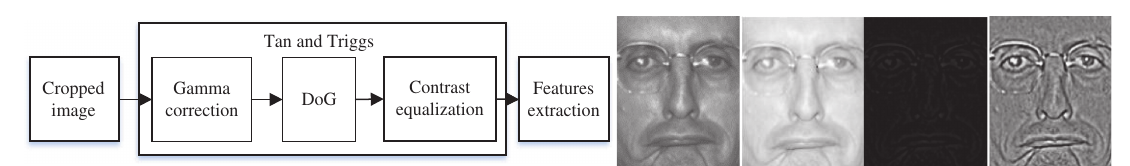
Figure 1: Preprocessing Step.